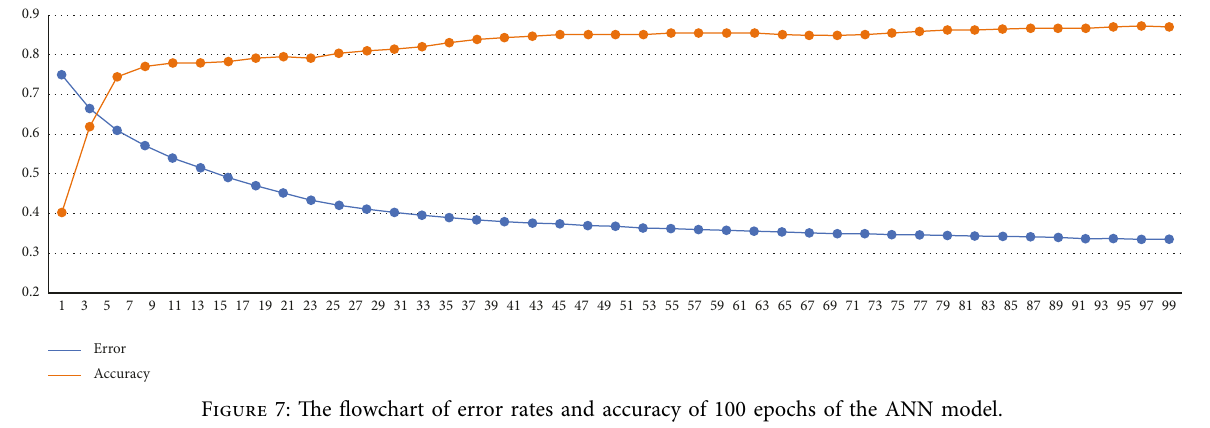
Figure 7: The flowchart of error rates and accuracy of 100 epochs of the ANN